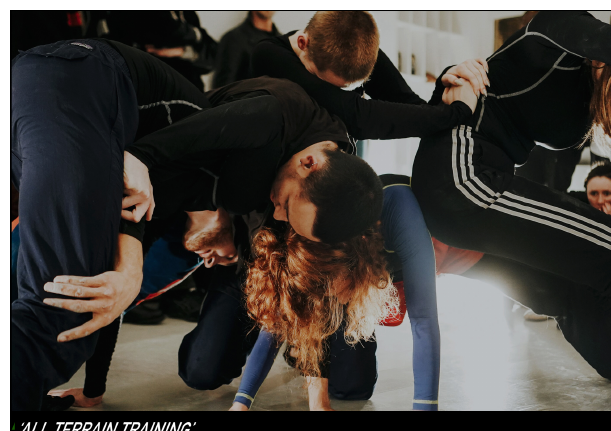
Figure 13. Artists perform a durational dance piece entitled All Ter- rain Training choreographed to sonified seismic data captured in the Wills Memorial Building tower that was amplified and live mixed during the event. The choreographed movements depict the colli- sion, shearing and spreading of the tectonic plates that produced the earthquakes to which the piece was performed. Photo credit: Rocio